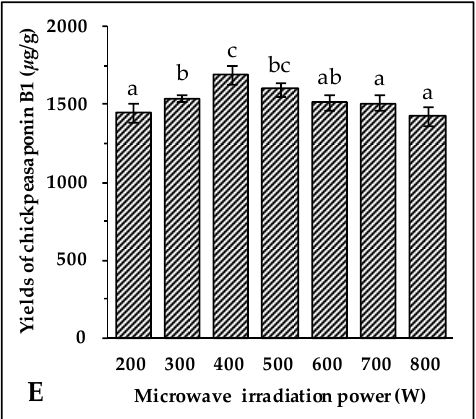
Figure 2. Effect of ethanol concentration ( A ); solid/liquid ratio ( B ); irradiation time ( C ); extraction temperature ( D ); and microwave irradiation power ( E ) on the yields of target compound. Data are expressed as the mean value ± standard deviation (S.D.) of triplicate experiments. Data marked with different letters “a”, “b”, “c”, “d”, “e”, or “f” have significant differences, p < 0.05, while those marked with the same letter denote no significant differences, p > 0.05. Data marked with “ab” or “bc” have no significant differences from those marked with “a” or “b”, “b” or “c”, p > 0.05, respectively.